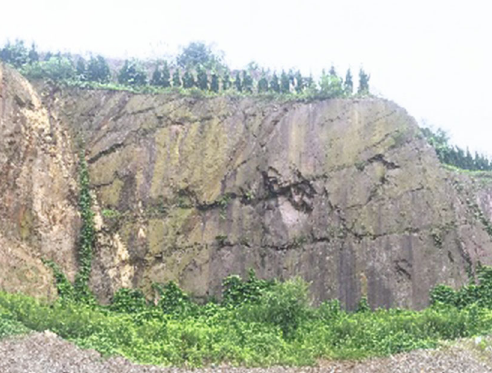
Figure 4: Mine slope in Shaoxing,